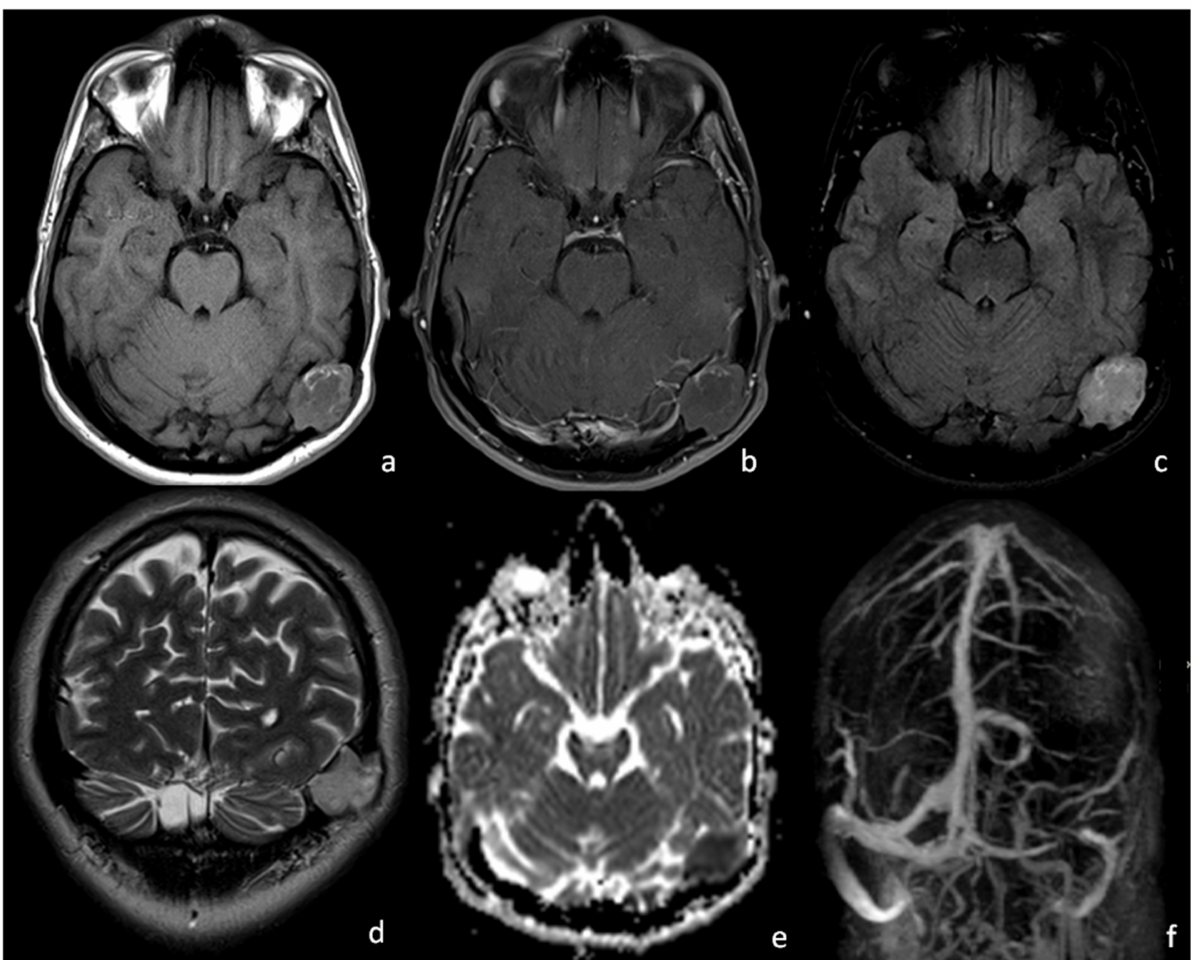
Figure 1. Case 1, 1.5 T MRI: on T1WI ( a ) there is evidence of a predominantly isointense left asterional mass with a surrounding, subtle, hyperintense rim; no signal enhancement is noted after gadolinium injection ( b ). The lesion appears to be unevenly hyperintense on FLAIR ( c ) and T2WI ( d ), with restricted signal on ADC ( e ). The 3D MIP reconstruction of contrast-enhanced MR venography ( f ) shows a severe stenosis of the left transverse–sigmoid sinus junction caused by the asterional dermoid